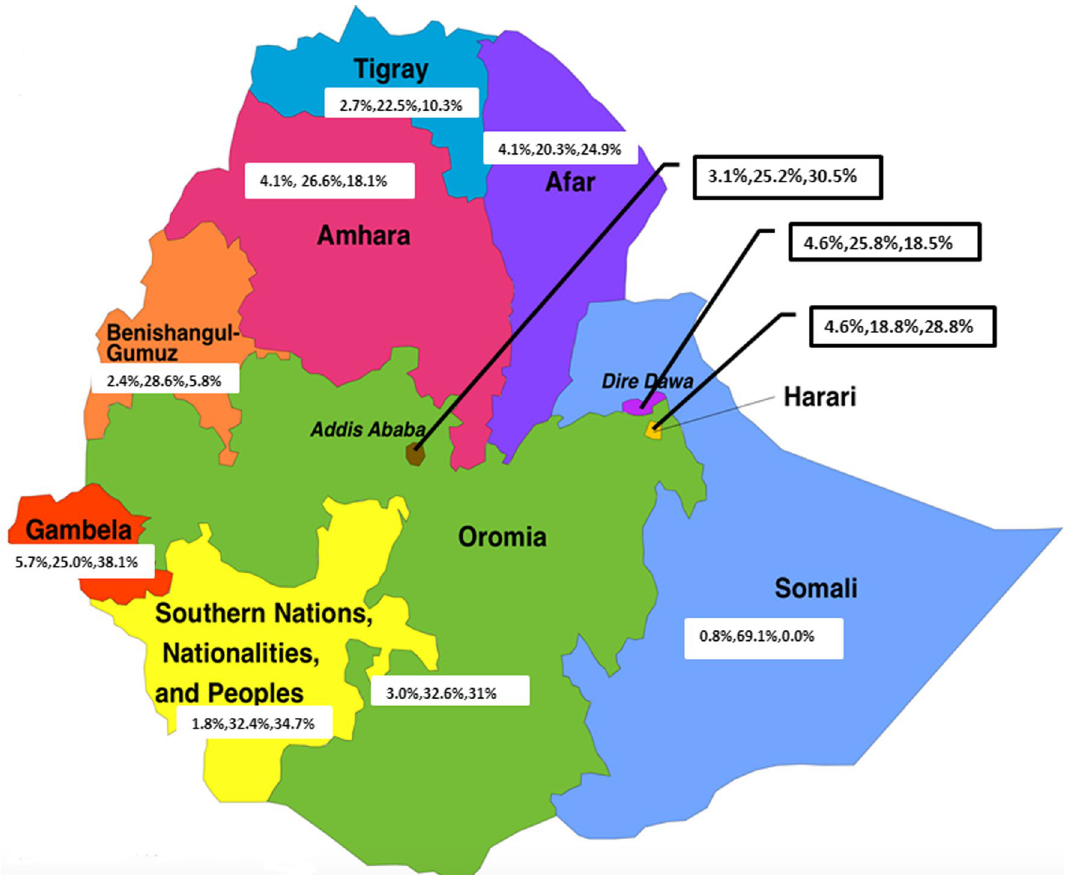
Fig. 2 Prevalence of HIV, magnitude of never tested and newly diagnosed long-term infection, respectively, among people in urban Ethiopia disaggregated by region,